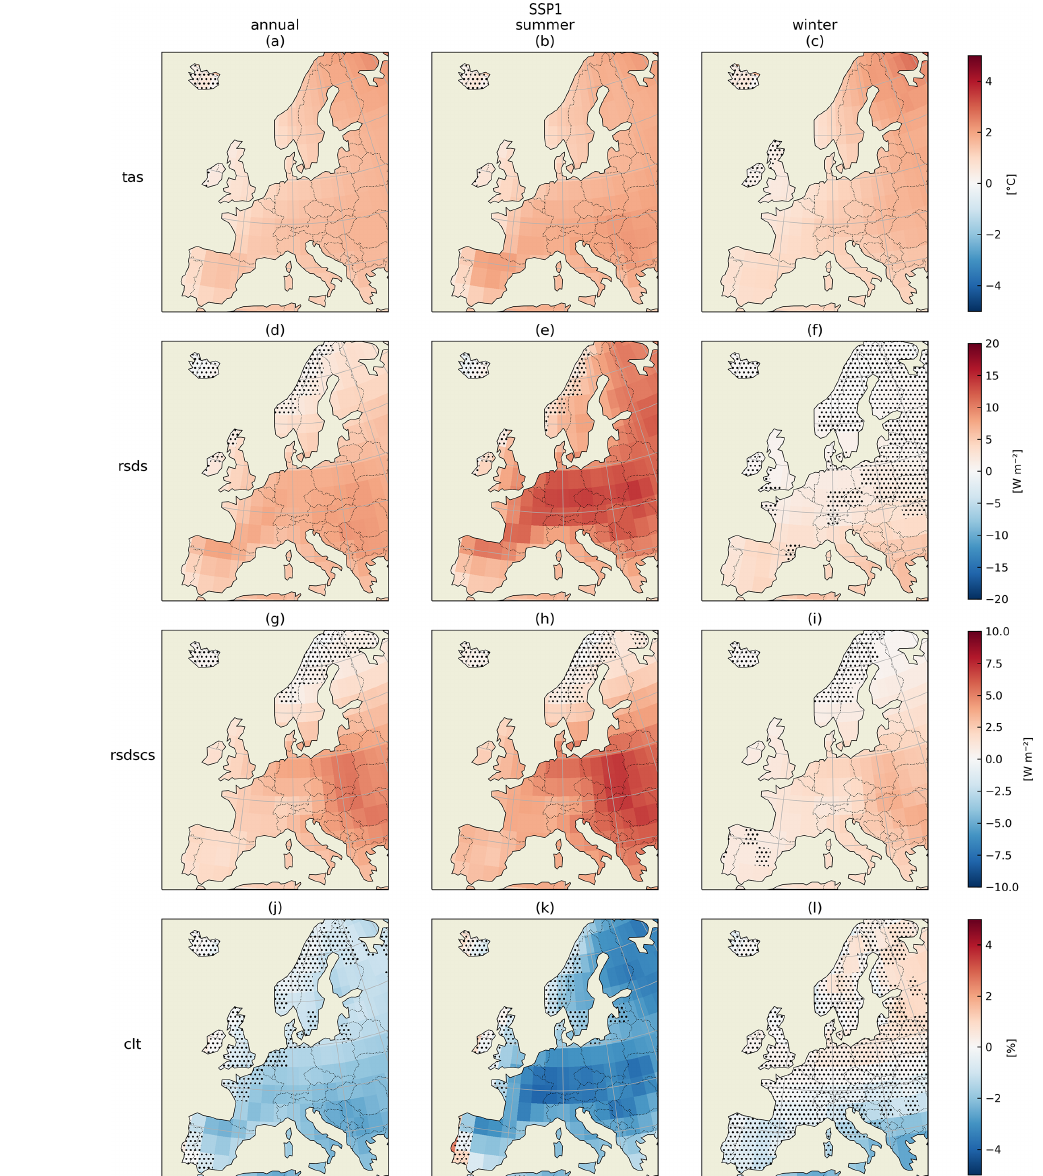
Figure 1. Change in climate variables relevant for PV production in SSP1-2.6. Maps show differences between 2081–2100 and 1995–2014 in the multi-model mean, calculated as future minus reference. Each row shows one variable, and each column refers to one period of interest. The variables are shown in the rows, in descending order, as follows: (a) – (c) temperature above surface (tas), (d) – (f) surface downward solar radiation (rsds), (g) – (i) surface downward clear-sky solar radiation (rsdscs), and (j) – (l) total cloud fraction (clt). The left column depicts the mean over the entire year, whereas summer (June, July, and August) and winter (December, January, and February) are displayed in the other two respective columns. The same variables share color bars with the same limits. The dots signify less than 75% model agreement in the sign of the projected